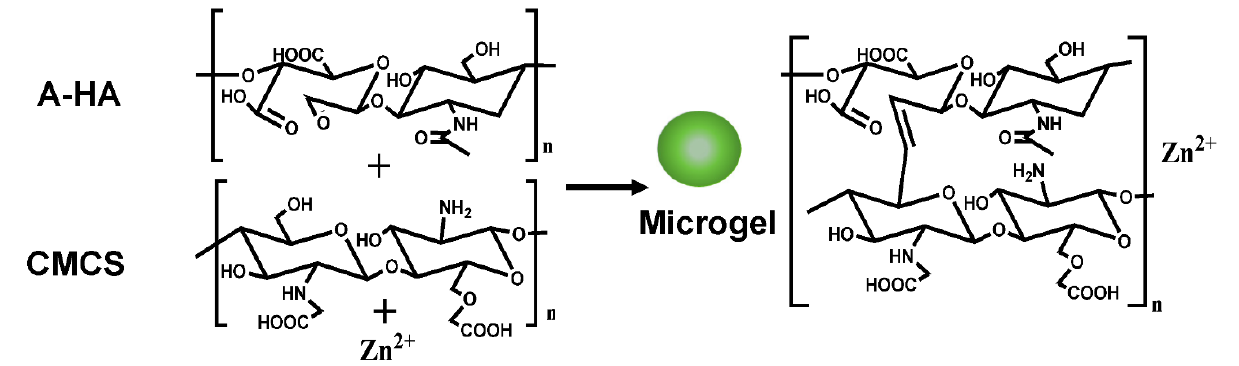
Figure 1 . The scheme of the microgel synthesis. Figure 1. The scheme of the microgel